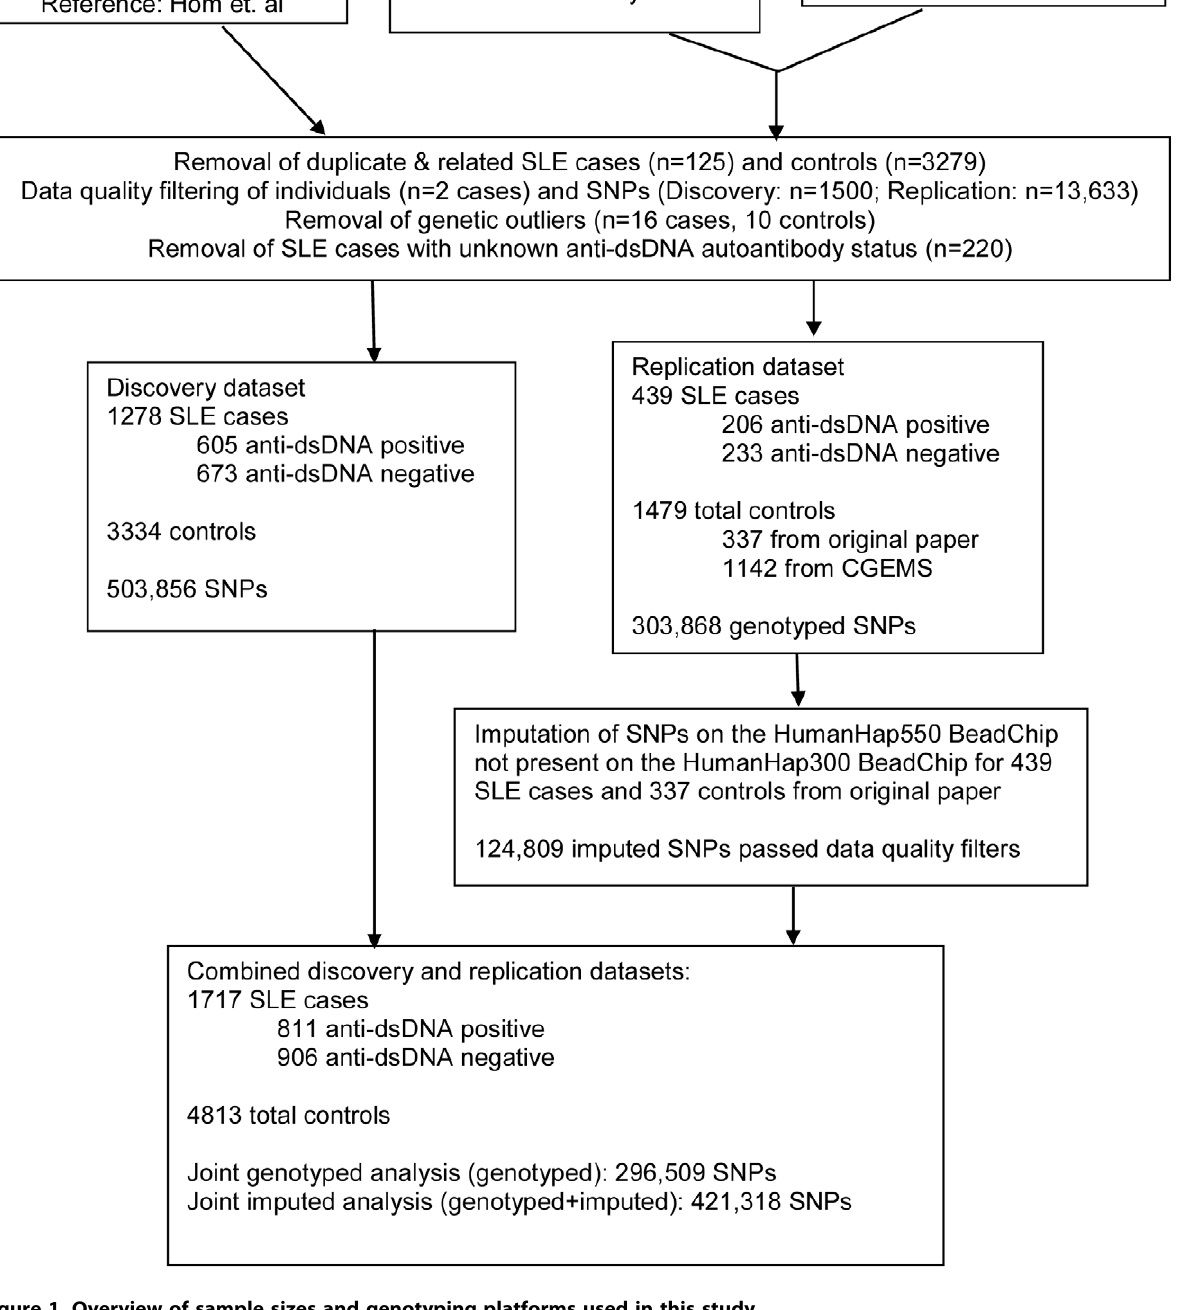
Suggestive findings of association in the joint dataset (p , 1E-05) were seen with SNPs near or in the PTTG1 , UBE2L3 , SLC1A7 , and KIAA1542 loci, and with rs10737562 (no known gene within 100 kb). PTTG1 , KIAA1542 , and UBE2L3 have been shown to be